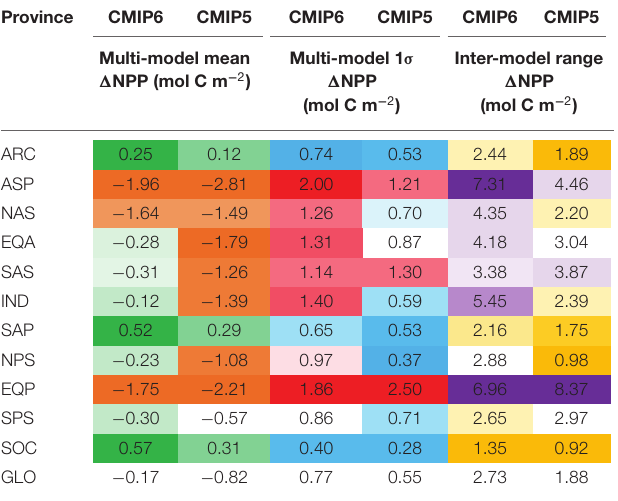
TABLE 3 | Statistics (as mol C m − 2 changes) for the multi-model mean, 1 σ “likely” range and the full inter-model range across different regions and globally for 16 CMIP6 and 10 CMIP5 models.